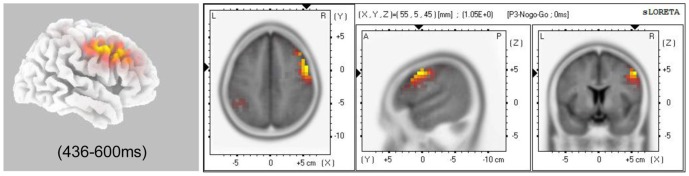
sLORETA solutions to non-parametric randomization tests on P3 temporal factor scores showing voxels in which the Nogo>Go contrast was significant (P<0.01).